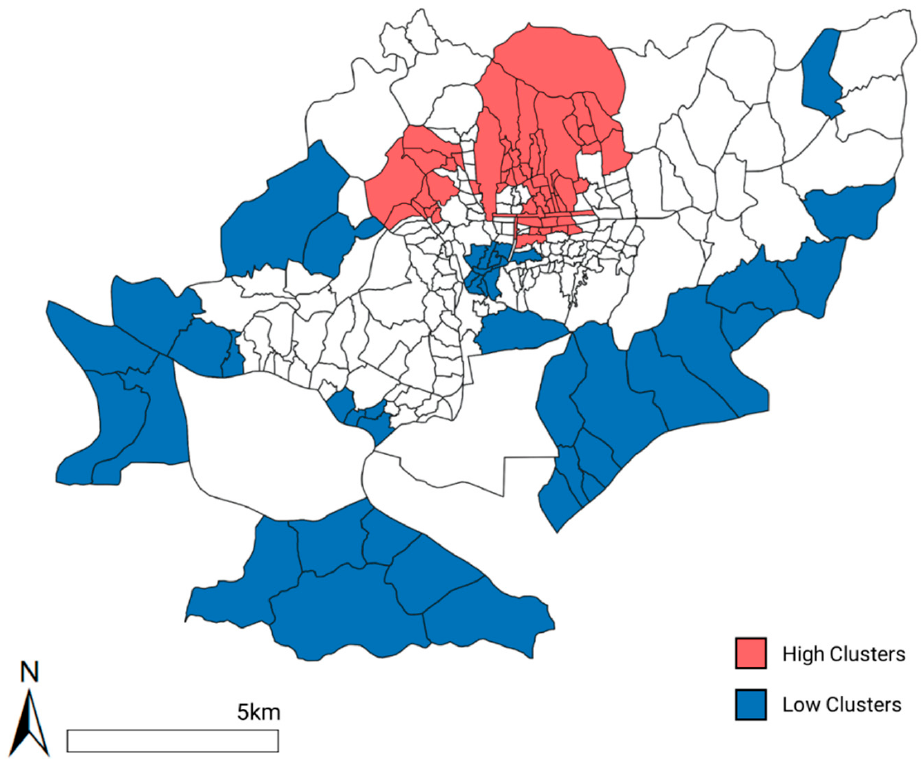
Figure 7. A cluster map (Getis‑Ord Gi*) of the neighborhood‑level unemployment rate. The red color indicates a significant high cluster of 57 neighborhoods with higher unemployment rates. The blue color indicates a significant low cluster of 43 neighborhoods with lower unemployment rates.